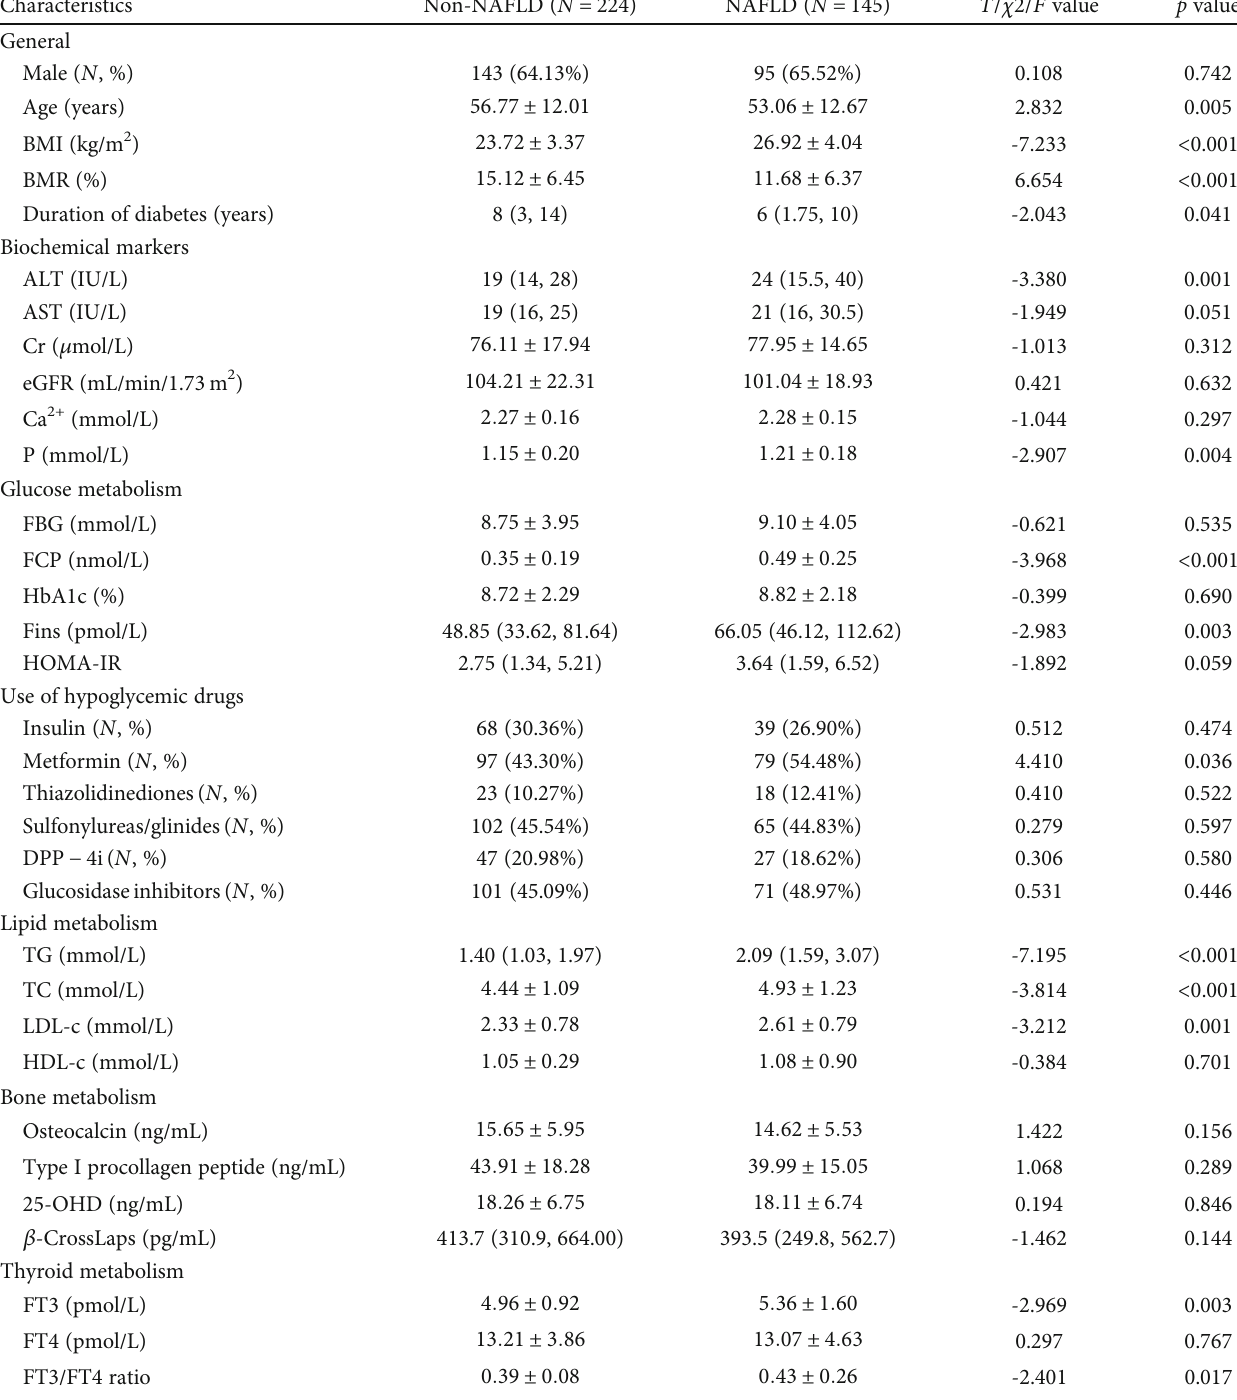
Table 1: Demographic and metabolic characteristics of study subjects by NAFLD